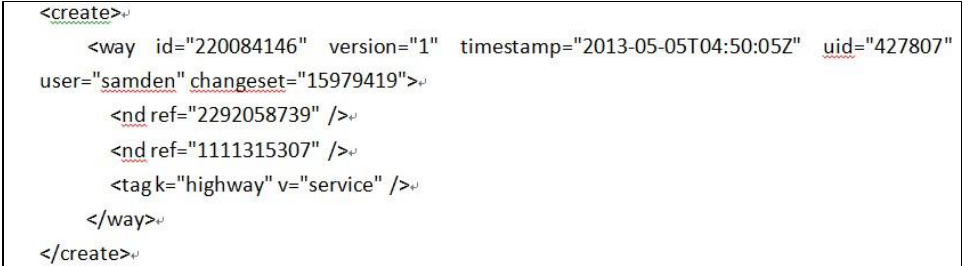
Figure 3. The OSM diff file format using the “create” way object section as an